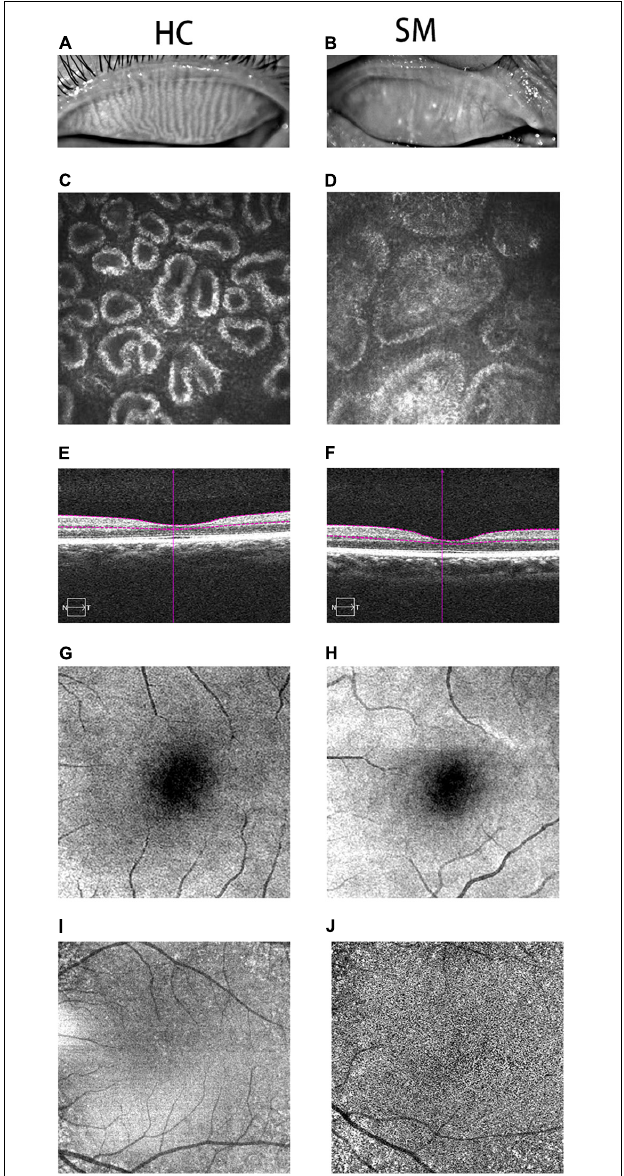
FIGURE 1 | Typical pictures of HC and SM groups. We photographed the changes of MGs in HC group (A) and SM group (B) . We can obviously observed that the MG in HC group is clearer than that in SM group. At the same time, we took pictures of the two groups of MGs with corneal confocal microscope, and we could observe the typical differences between the two groups of MGs. The MG in SM group was obviously blocked, and it was widened at the same time (D) . Meanwhile, we could observe the normal MG in HC group (C) . Therefore, it could be speculated that severe obesity may lead to tarsal gland blockage and degeneration. According to the cross-sectional observation image of retinal thickness in the control group, we could observe that the choroidal thickness in the SM group (F) was significantly thinner than that in the HC group (E) . According to the fundus angiography images we obtained, we also observed that the capillaries in HC group (G,I) were more developed than those in SM group (H,J) , indicating that severe obesity may reduce the thickness of choroid and fundus blood supply, and may further cause fundus disease. HCs, healthy controls; SM, severe obesity and meibomian gland dysfunction; MG, meibomian gland.